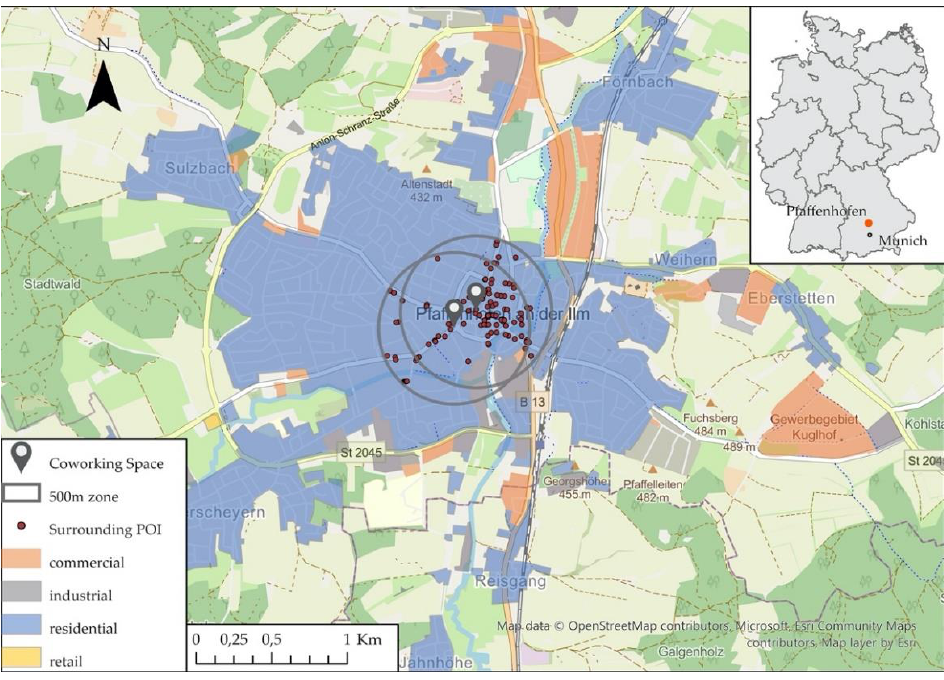
Figure 11. Map of POIs as listed in Table 2 in a radius of 500 m around coworking spaces (CWSs) in Pfaffenhofen an der Ilm (without scale) source: ArcGIS ® software by Esri, OSM, gefabrik.de, coworkingmap.de, © GeoBasis-DE/BKG (2020).